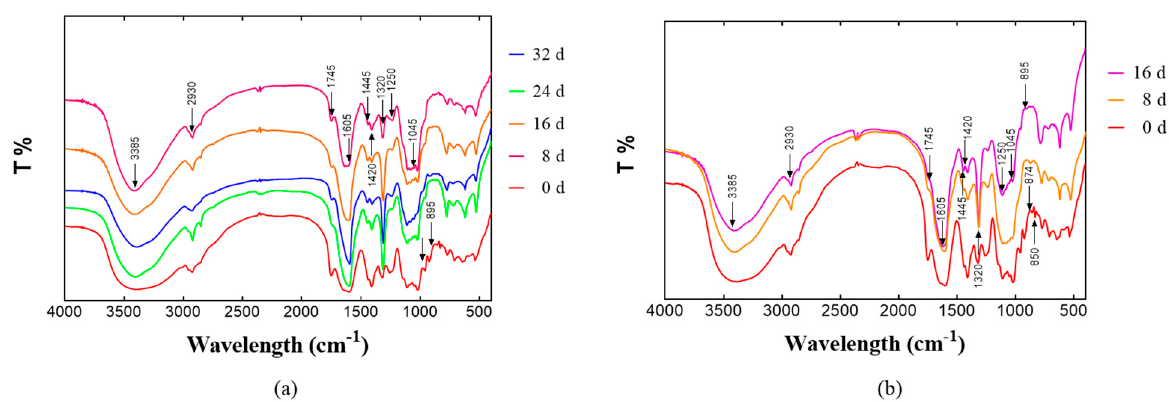
Figure 4. FT-IR spectra of water-soluble polysaccharides isolated from Z. latifolia at different storage periods. ( a ) Storage at 4 ℃ , ( b ) storage at 25 °C.